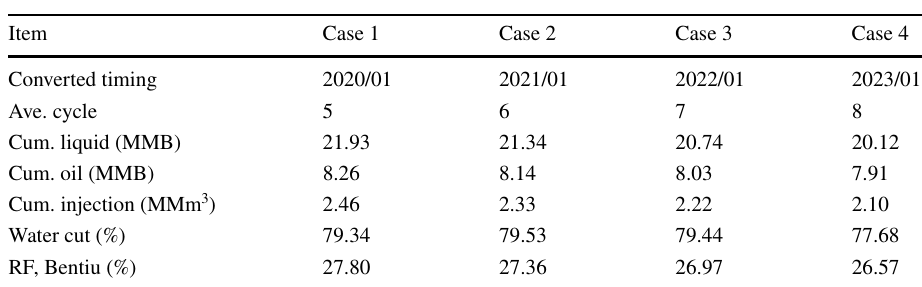
Table 4 Forecast index of converting to SF timing cases